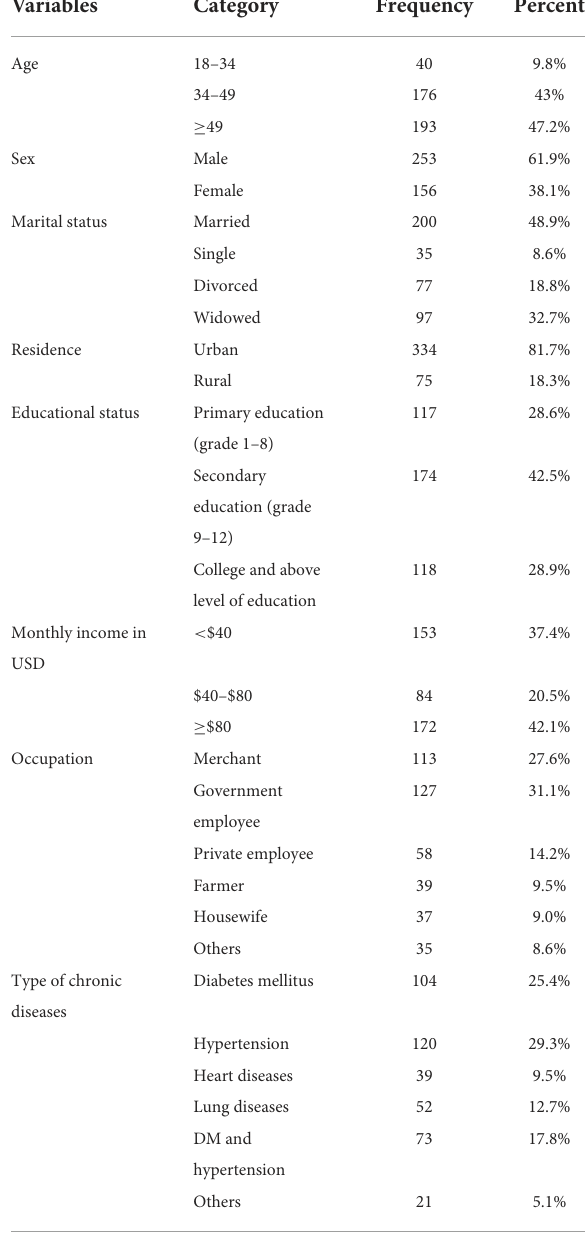
TABLE 1 Sociodemographic and clinical characteristics of patients with chronic diseases, southern Ethiopia, 2021 ( N =